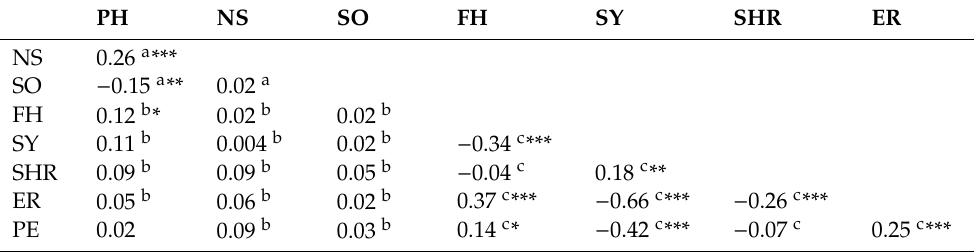
Table 3. Pearsons correlation coe ffi cient between the eight characteristics studied in the F 2 population or in its F 3